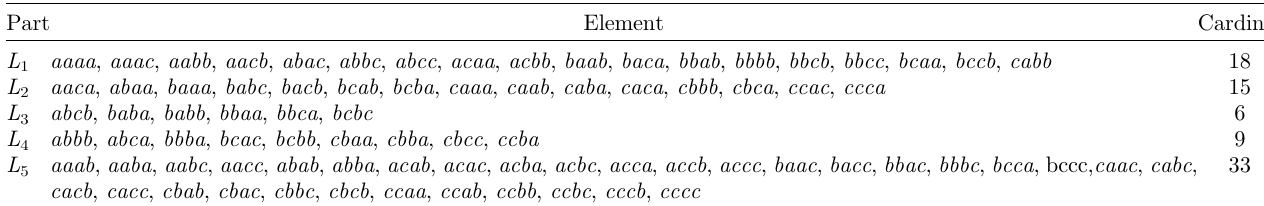
Table 5. Estimated partition for the state space { a , b , c } 4 – procedure (i). Part